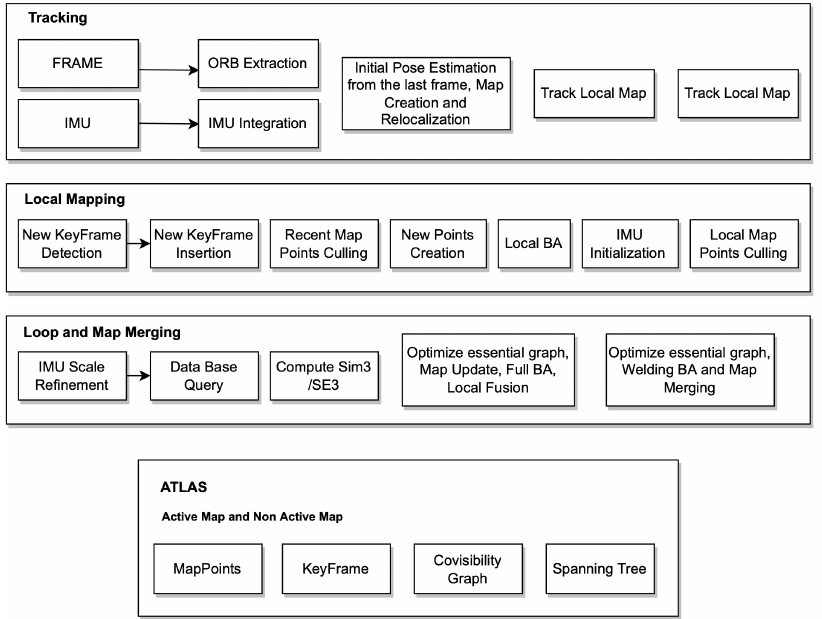
Figure 1. ORB-SLAM3 system